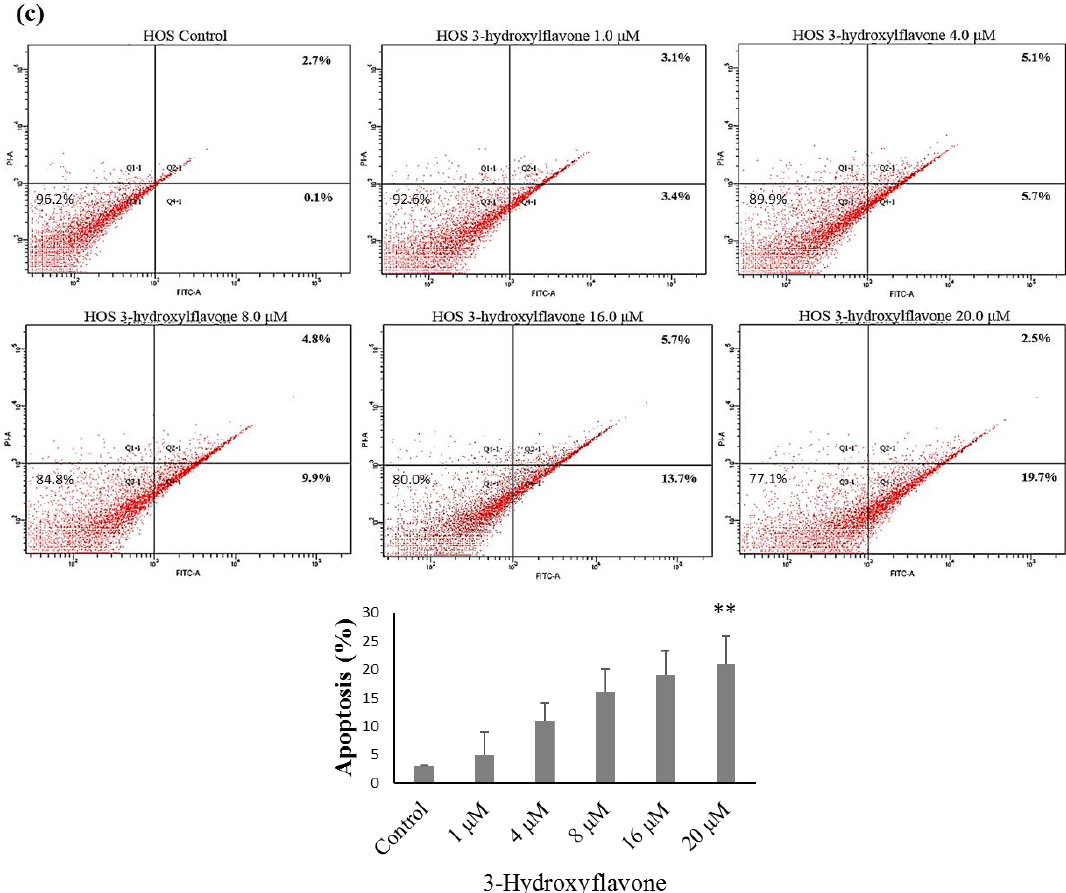
Figure 2. E ff ect of 3-HF on mitochondrial membrane potential and apoptosis in HOS cells. ( a , b ) Cells were seeded on 6-well plates and treated with 0, 1.0, 4.0, 8.0, 16.0, or 20.0 µ M of 3-HF for 24 h. ( a ) The apoptotic e ff ect detected by TUNEL assay and DAPI staining in human OS cells. ( b ) Fluorescence image of human OS cells stained with JC-1 after 24 h incubation with di ff erent concentrations of 3-hydroxyflavone. Photograph showing JC-1 red, JC-1 green and merge image. The JC-1 green fluorescence indicates a decrease in mitochondrial membrane potential, an event in apoptosis. Increased concentrations of 3-HF enhanced the loss of mitochondrial membrane potential. Scale bars indicate 100 µ m at 20 × magnification ( c ) The percentage of apoptotic cells in 3-HF groups increased significantly compared with the control group (parental cells). Flow charts: Q4, annexin V-positive and propidium iodide (PI)-negative cells indicate early apoptotic cells; Q2, annexin V- and PI-positive cells represent late apoptotic cells. ** p < 0.01 represents significance with respect to the control group.